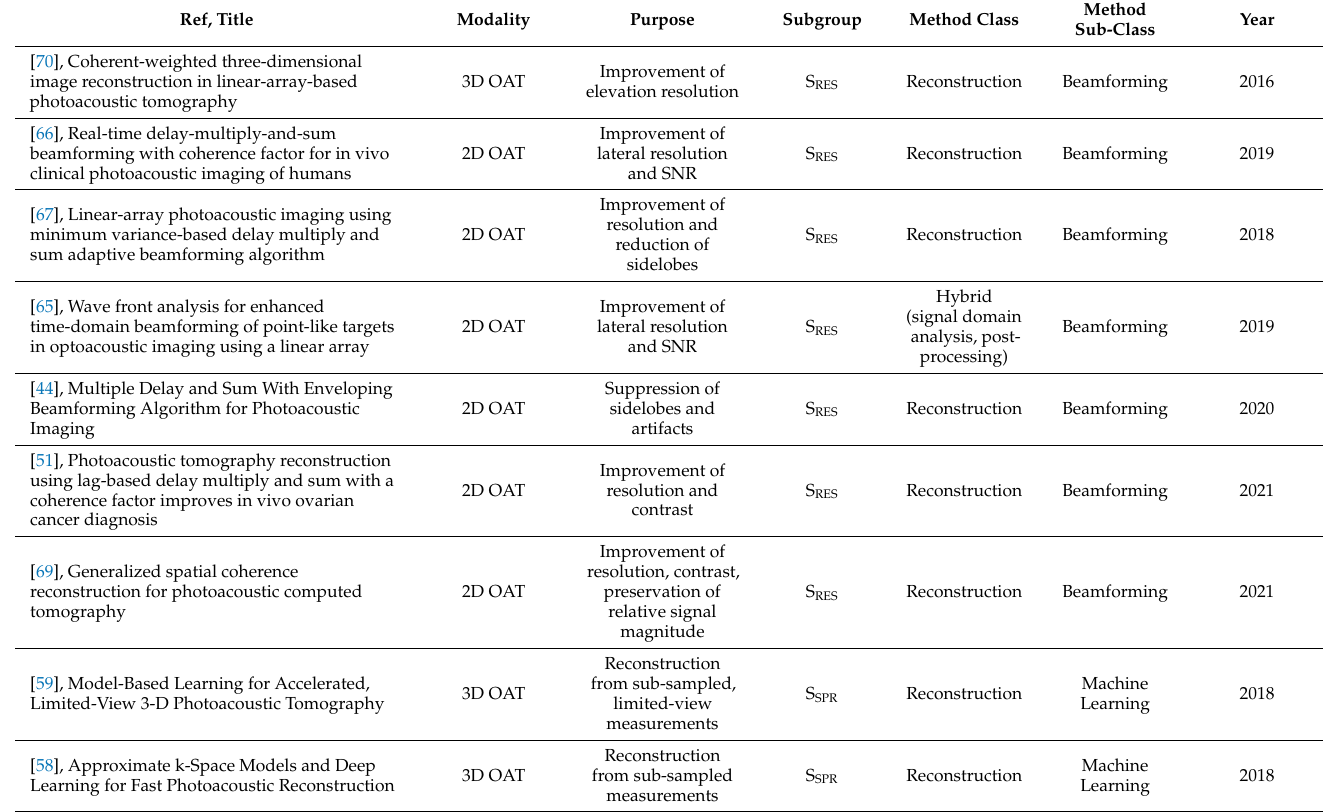
Table 6. Summary of the identified reconstruction and hybrid approaches. OAT: optoacoustic tomography, MSOT: multispectral optoacoustic